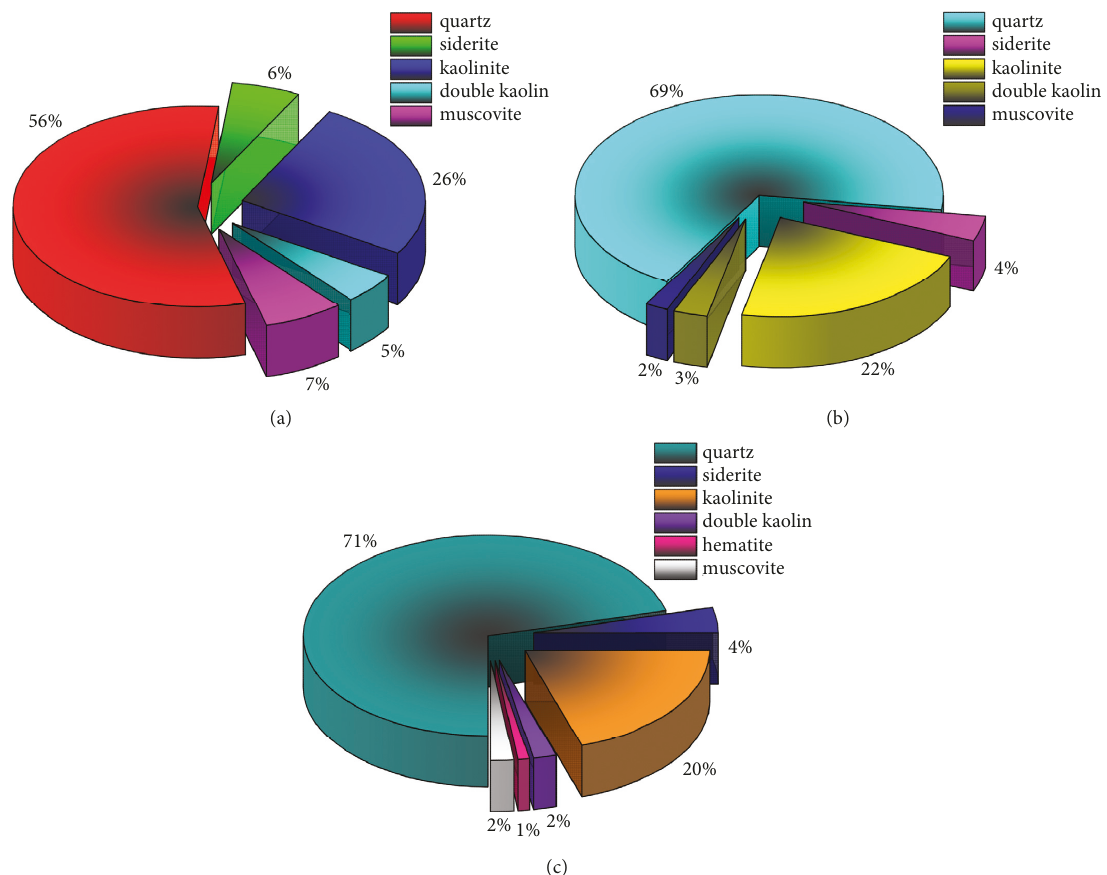
Figure 3: Mineral composition ratio of rock specimens. (a) Specimen 1 mineral composition. (b) Specimen 2 mineral composition. (c) Specimen 3 mineral